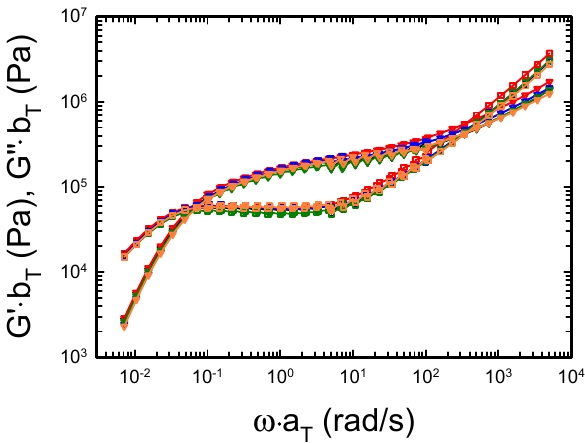
Figure 3. Mastercurves from data in Figure 2. The reference temperature is 150 °C. The color legend is the same as in Figure 2.